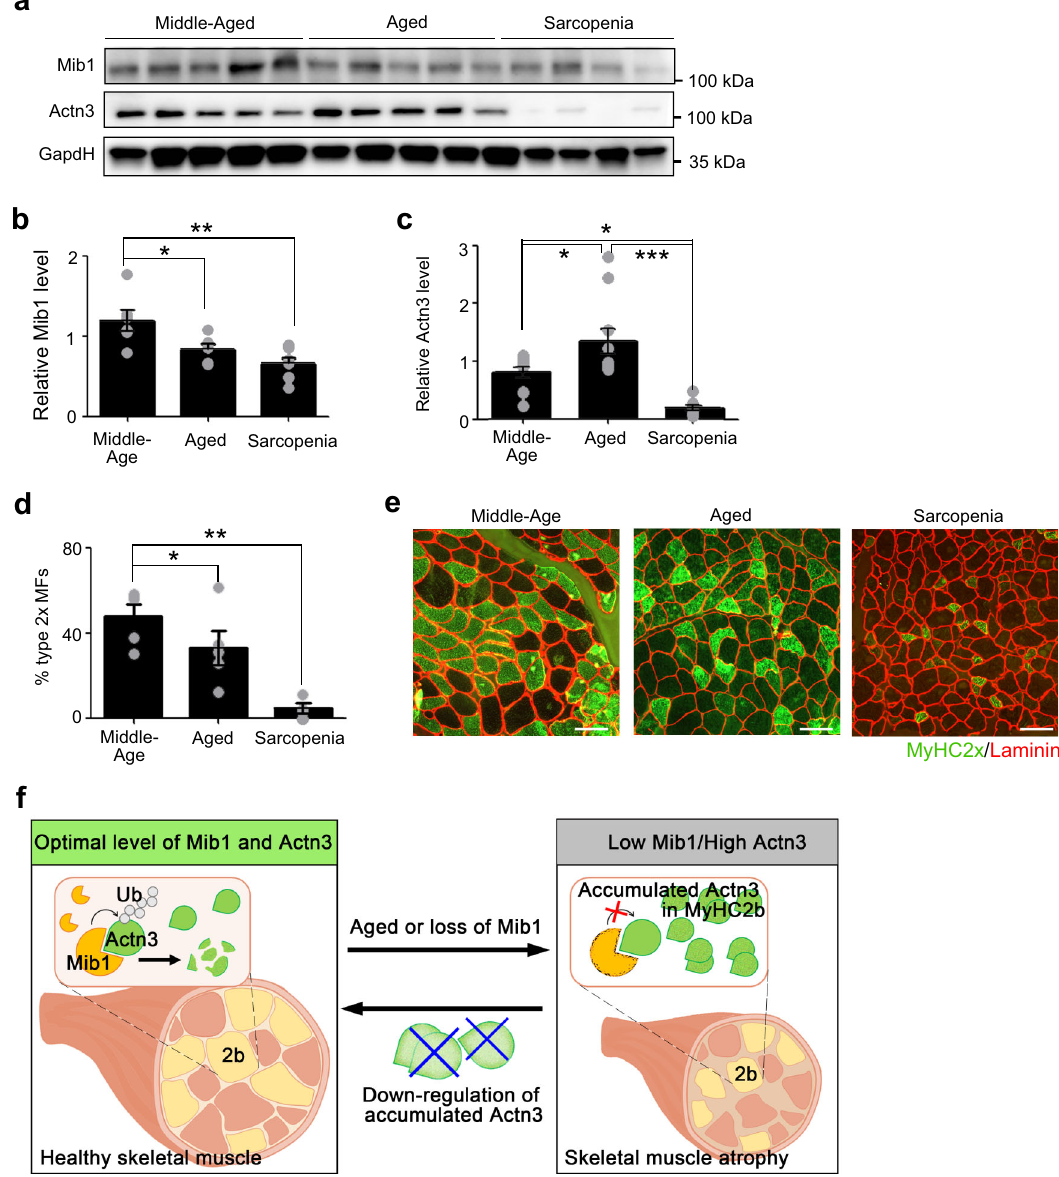
Fig. 6 Disturbed Mib1 – Actn3 axis in human skeletal muscle with age. a – c IB analysis ( a ) of Mib1 and Actn3 in vastus lateralis muscles of middle-aged (<60 years), aged (>60 years), and sarcopenia (>60 years and meet AGWS criteria), and quanti fi cation of Mib1 ( b ) and Actn3 ( c ). Please see Supplementary Fig. 7a for fl ow chart of selection of human subjects. The intensity of Mib1 and Actn3 expression at indicated group was quanti fi ed by densitometry. d , e Quanti fi cation of the percentage of type 2× glycolytic myo fi bers ( d ) and e representative images of IHC staining for MyHC2x (green; type 2× glycolytic myo fi bers) and laminin (red). Scale bars, 100 μ m ( e ). Data are presented as means ± s.e.m. Data are shown as representatives of at least three independent experiments. n = 6 for middle-aged and aged group, and 8 for sarcopenic group ( a – c ). n = 5 for the middle-aged and aged group, and 4 for sarcopenic group ( d ). One-way ANOVA for ( b – d ). * P < 0.05; ** p < 0.01; *** p < 0.001. f A proposed model. In healthy myo fi bers, Mib1 regulates Actn3, a Z-disk protein highly expressed in type 2 glycolytic myo fi bers, in a proteasome-dependent manner to maintain the optimal levels of Actn3. However, the age-associated changes in or loss of Mib1 in myo fi bers lead to the accumulation of Actn3 accompanied by the alteration of type 2 glycolytic myo fi bers, muscle atrophy, impaired muscle function, and, consequently, an acceleration of age-associated muscle atrophy. When the excessive accumulation of Actn3 is alleviated by the downregulation of Actn3 in myo fi bers, the muscle atrophy is ameliorated, suggesting that Actn3 can be a promising therapeutic target of age-associated muscle